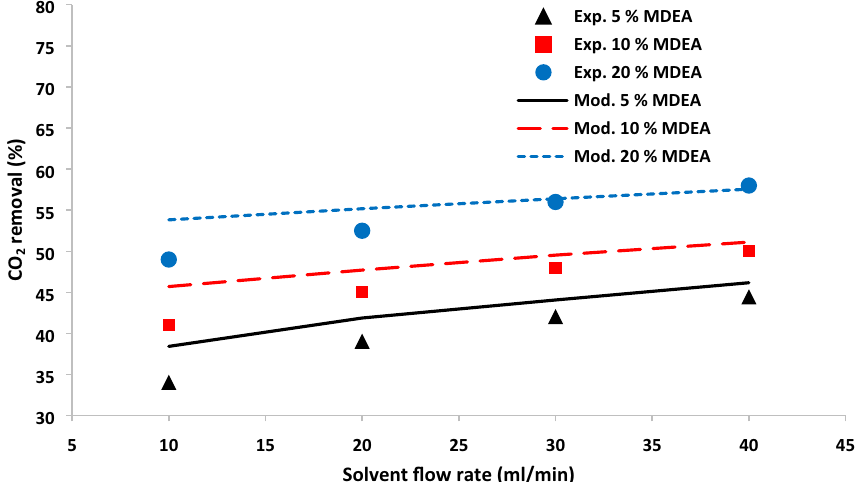
Figure 3. CO 2 removal % as a function of solvent flow rate at different MDEA concentration without NPs at 10 ml/min gas flow rate.